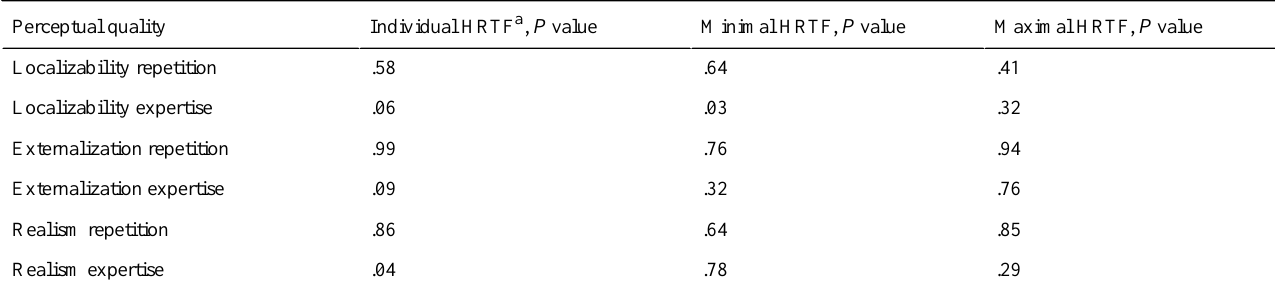
Table 3. Significance values of the subgroups for localizability, externalization, and realism in the second